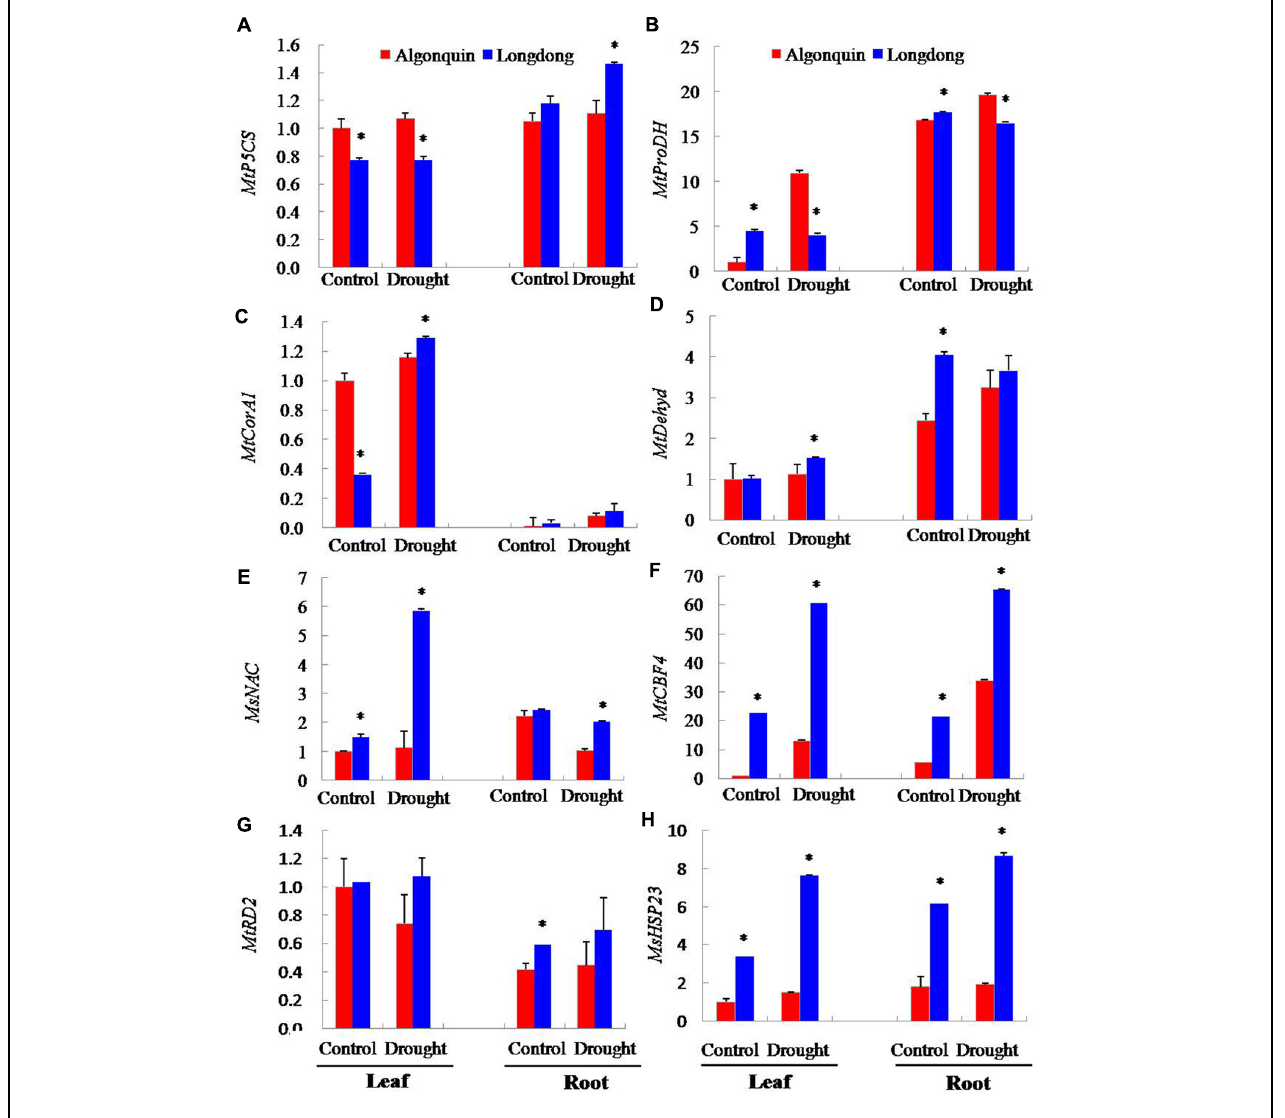
FIGURE 9 | Transcriptional expression of drought responsive genes in leaf and root after drought stress. (A–H) Changes in expression of MtP5CS , MtProDH , MtCorA1 , MtDehyd , MsNAC , MtCBF4 , MtRD2, and MsHSP23 genes in leaf and root of alfalfa plant after 12 days of drought treatment. The results shown are means ± SE ( n = 3). Asterisk symbols indicate significant differences at P < 0.05 (Student’s t